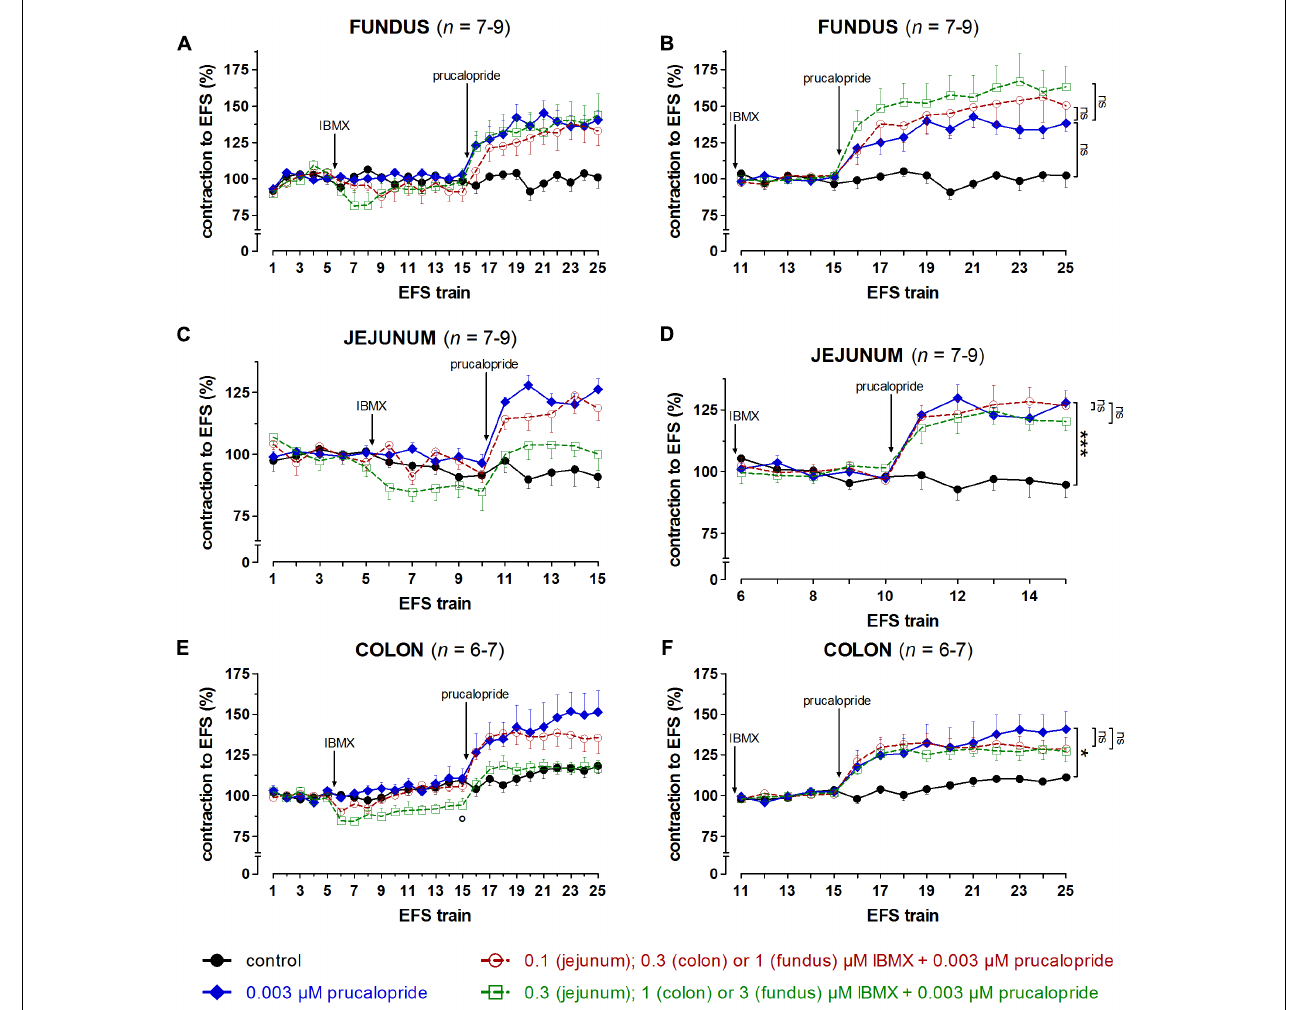
FIGURE 8 | Influence of IBMX in a concentration of 1 and 3 µ M (fundus), 0.1 and 0.3 µ M (jejunum), and 0.3 and 1 µ M (colon) on the facilitating effect of 0.003 µ M prucalopride on submaximal electrically induced cholinergic contractions at V 50% (10 s trains at 4 [fundus] or 8 [jejunum and colon] Hz, 0.5 ms, interval of 5 [fundus and colon] or 10 [jejunum] min) in murine fundus (A,B) , jejunum (C,D) , and colon (E,F) circular smooth muscle strips. The number of the consecutive stimulation trains is given on the y-axis. Contractions are expressed as percentage of the mean of the five contractions before adding IBMX (trains 1–5; A,C,E ) or of the five contractions in the presence of IBMX just before adding prucalopride (trains 11–15 for fundus and colon; trains 6–10 for jejunum; B,D,F ). Experiments were performed in the continuous presence of 4 µ M guanethidine, 300 µ M L-NAME, and for colon also 1 µ M MRS 2500. Means ± SEM. Left panels, last EFS-induced contraction in the presence of PDE inhibitor before adding prucalopride: ◦ P < 0.05 versus control (unpaired t -test). Right panels, last EFS-induced contraction: ns not significant, ∗ P < 0.05, ∗∗∗ P < 0.001 (one-way ANOVA with Bonferroni corrected t -test for three comparisons i.e., prucalopride versus control and both concentrations of IBMX versus